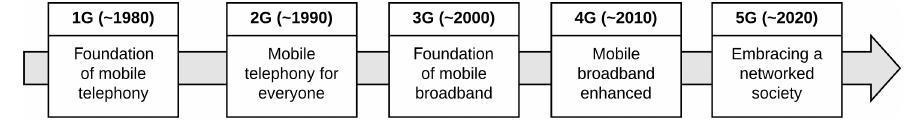
Fig. 7 Cellular generation